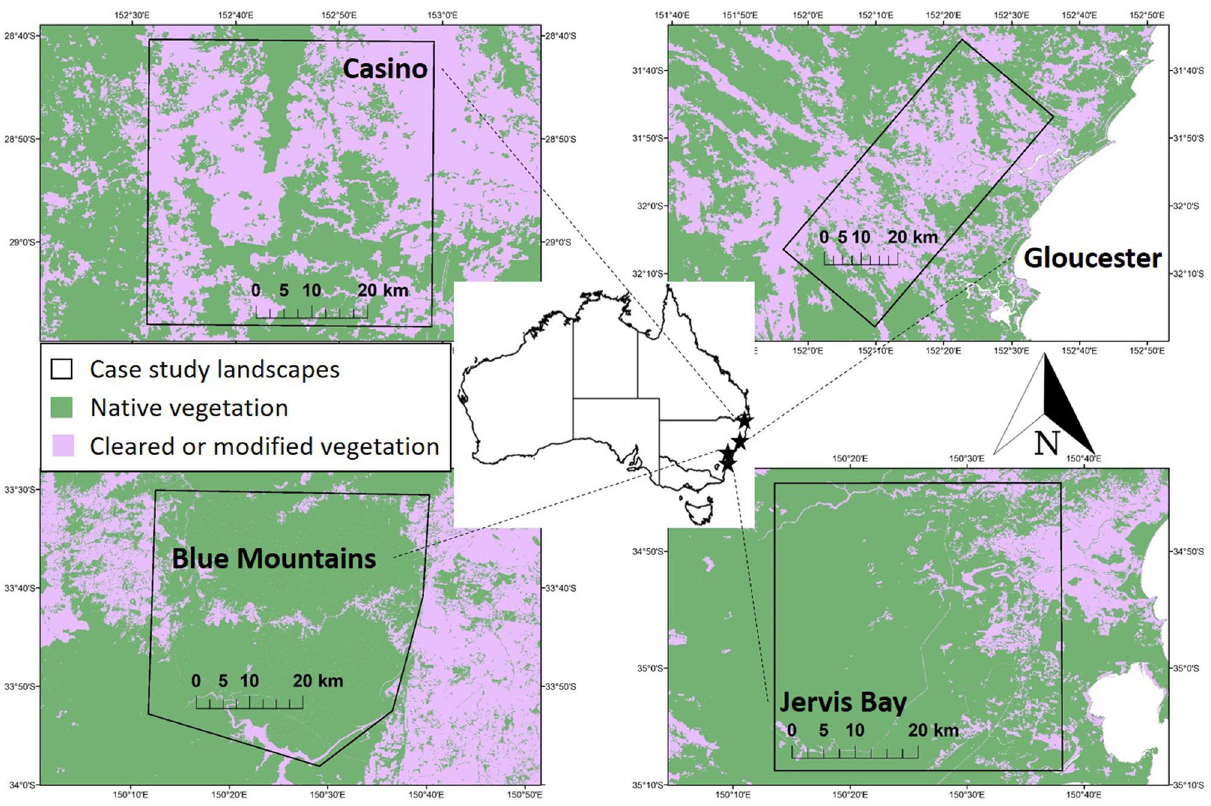
Figure 1.. Fire behaviour simulations were carried out for four case study landscapes in south-eastern Australia: Casino, Gloucester, Blue Mountains and Jervis Bay. See Table 1 and Study Area in the Methods section for more information. This figure was generated using ArcGIS version 10.8 (https:// www. esri. com/ en- us/